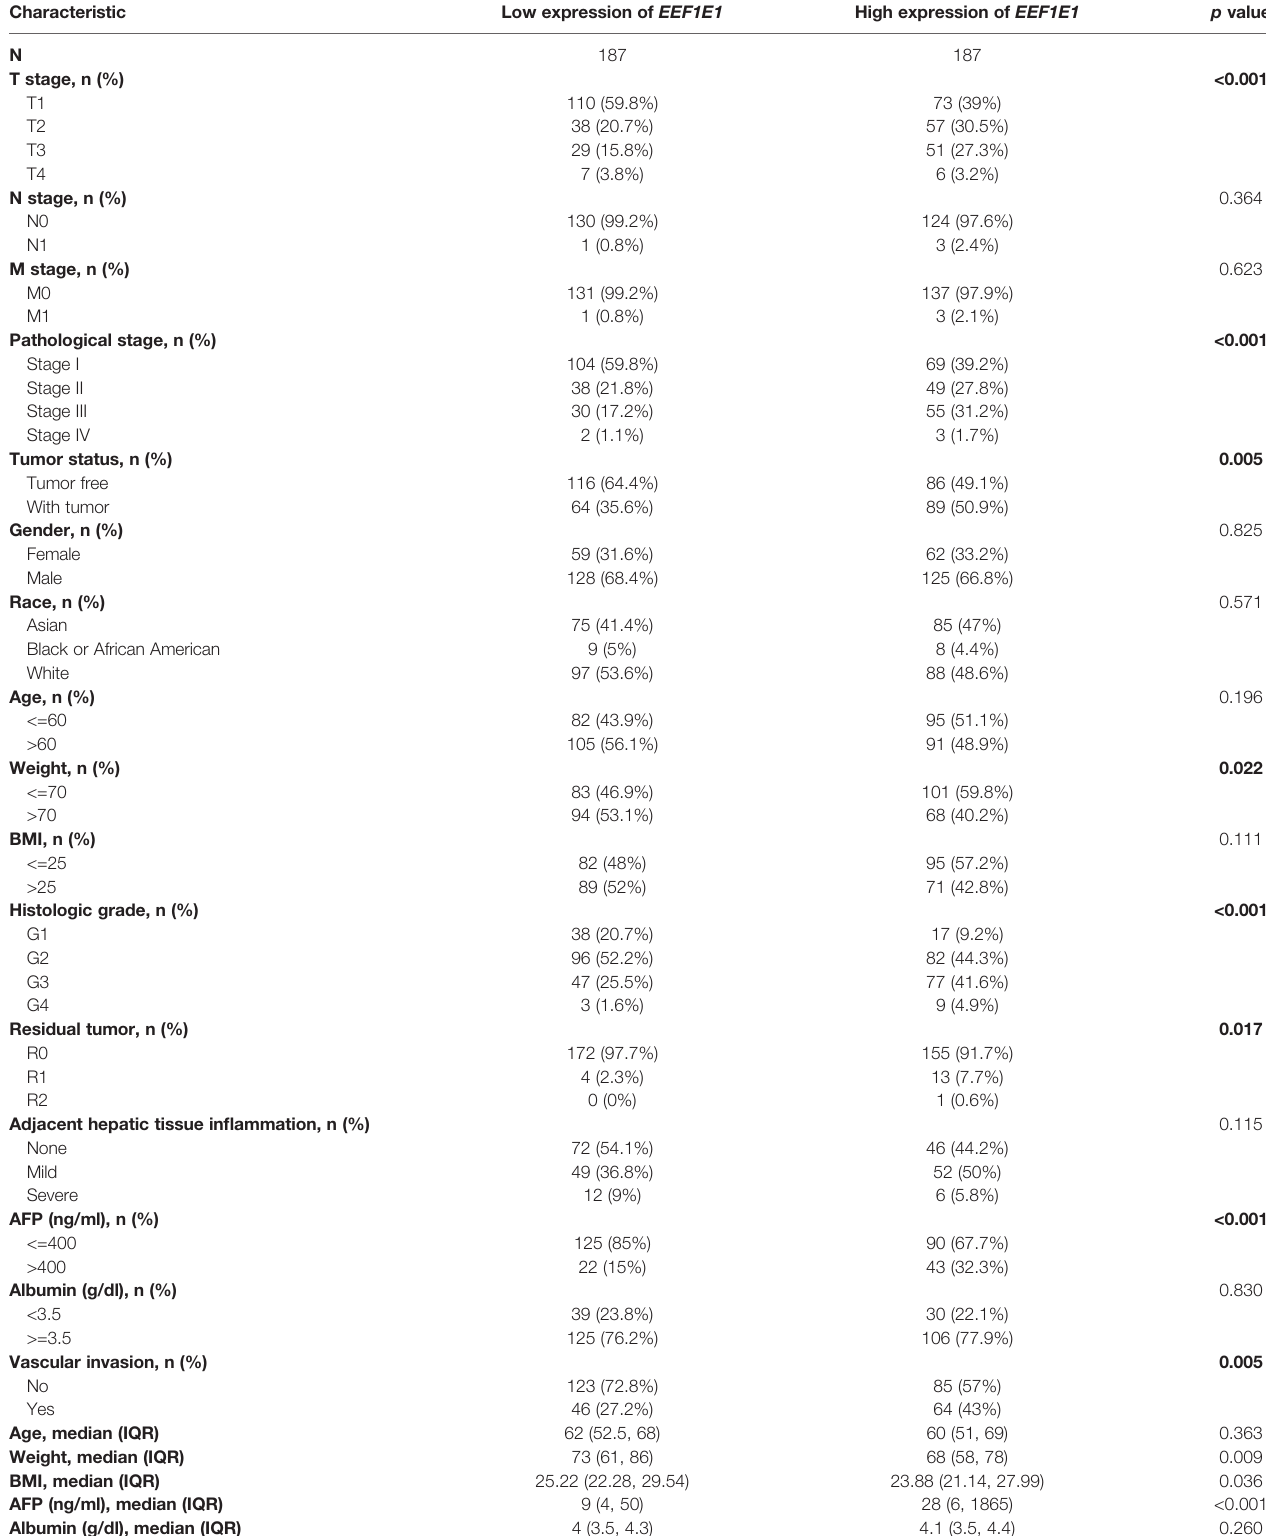
TABLE 1 | TCGA liver cancer patient characteristics and EEF1E1 expression correlated with clinical-pathological characteristics (cox regression).